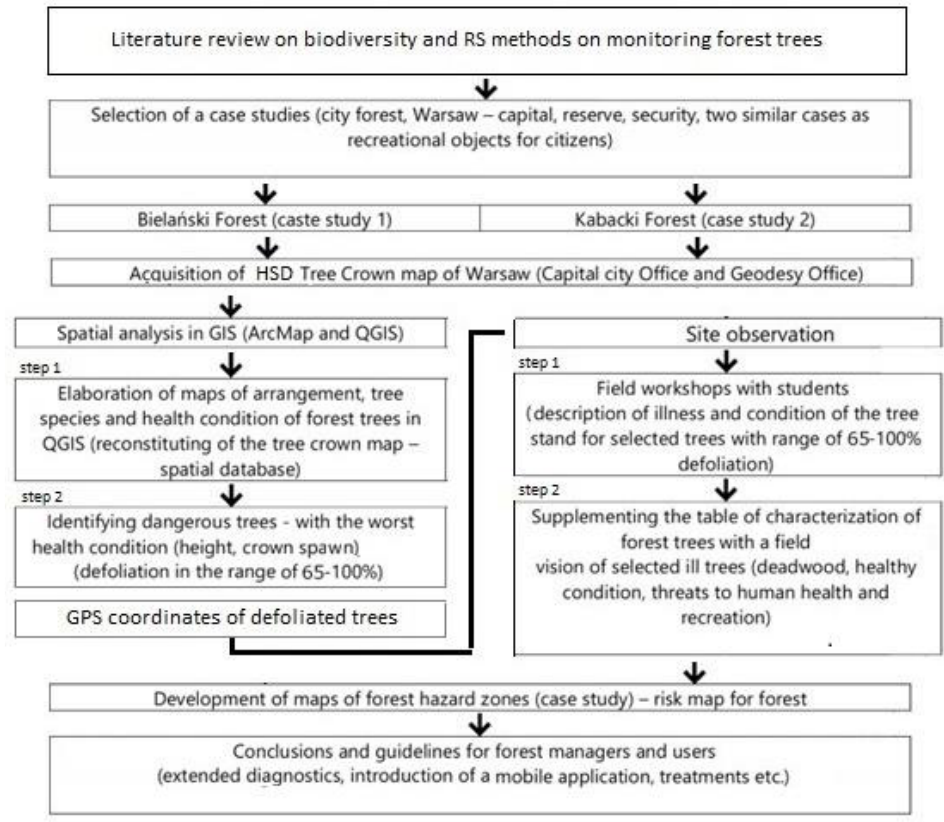
appendices (tables of attributes of defoliated trees for the Biela´nski Forest—Table S1, and for the Kabacki Forest—Table S2).